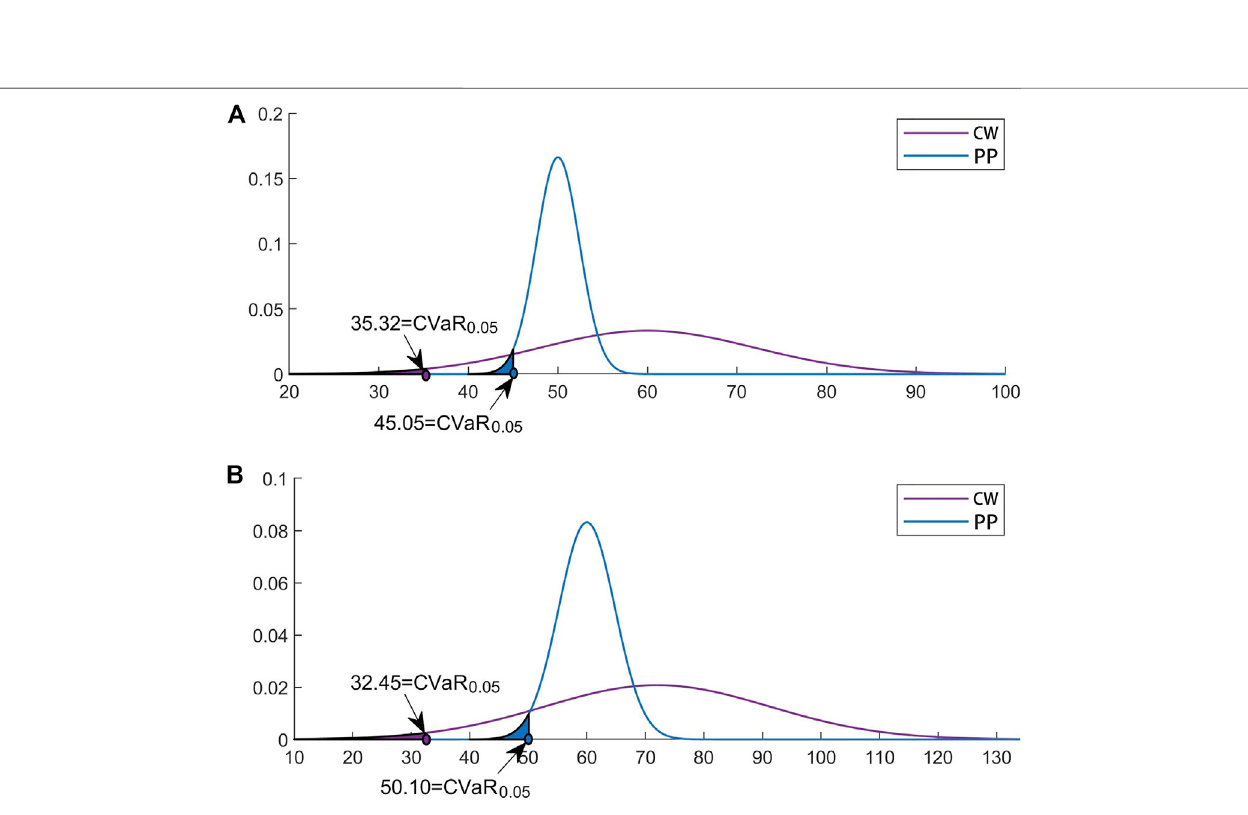
Frontiers in Environmental Science |